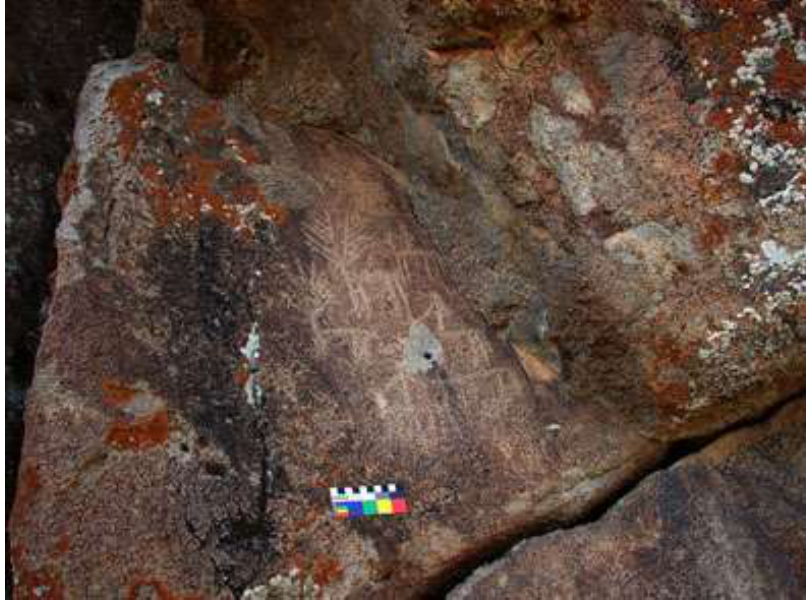
Figure 20. Dehgolan, Zafar Awa village, part of a petroglyph, three “horse riders” chasing two “antelopes”. In the middle of the picture, human destruction can be